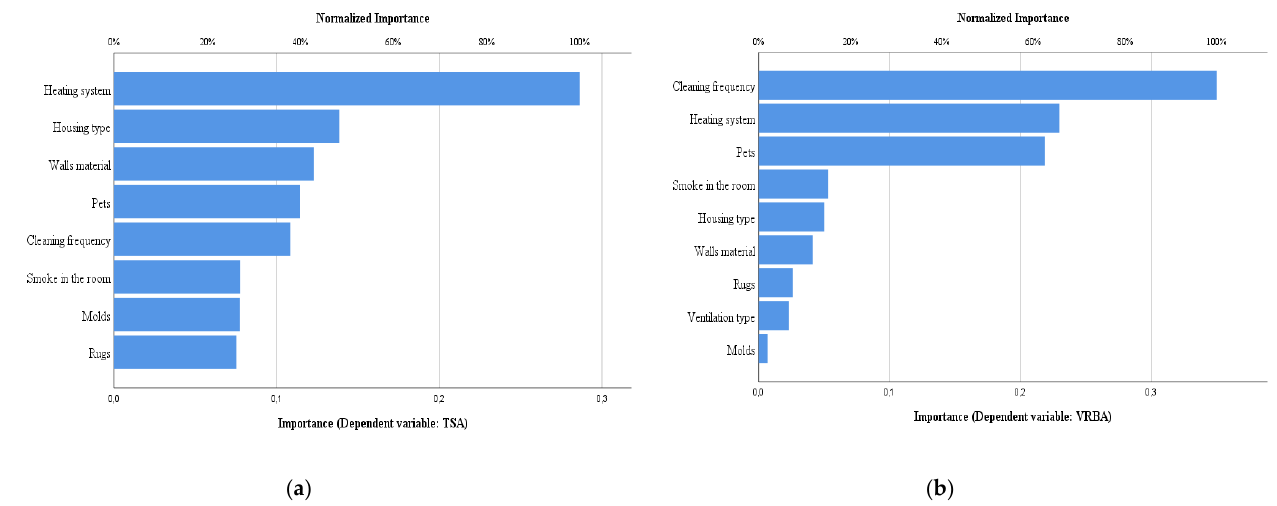
Figure 5. Normalized importance of housing characteristics for bacterial counts. ( a ) TSA, ( b ) VRBA.